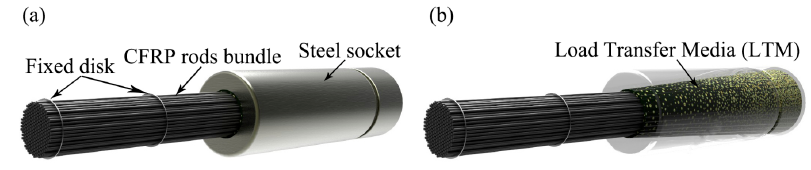
Figure 9. Gradient Anchorage System, ( a ) full view and ( b ) transparent view.